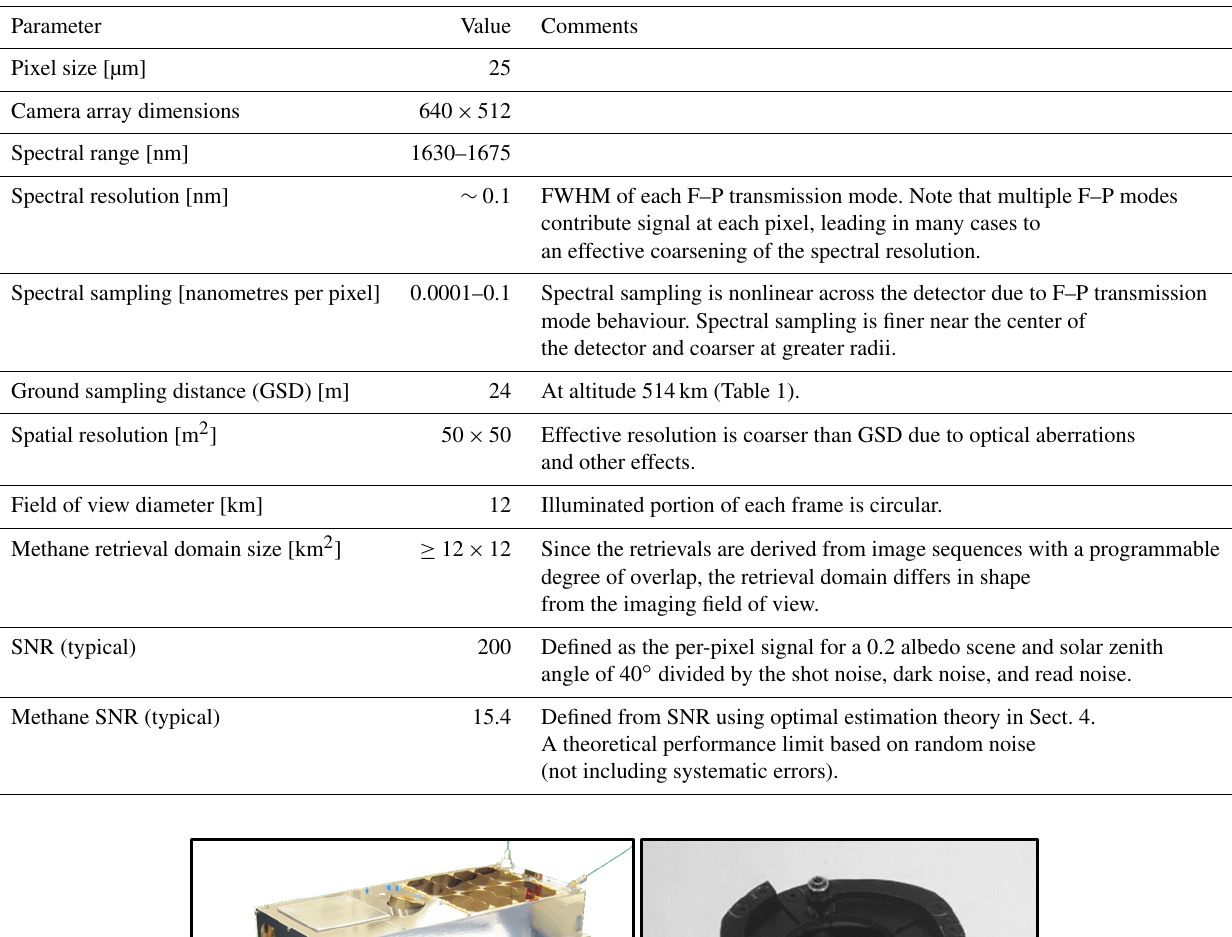
Table 2. Instrument parameters.